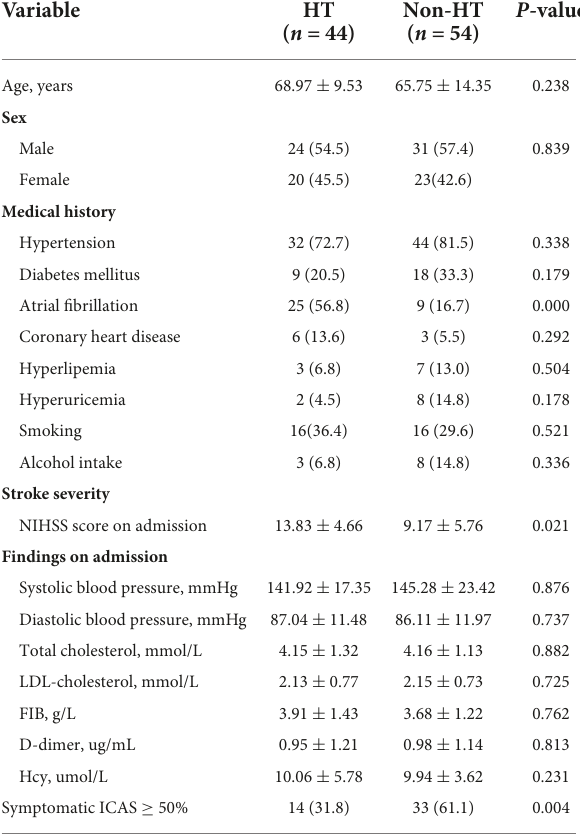
TABLE 1 Baseline demographic and clinical characteristics of patients with and without hemorrhagic transformation (HT). Variable HT